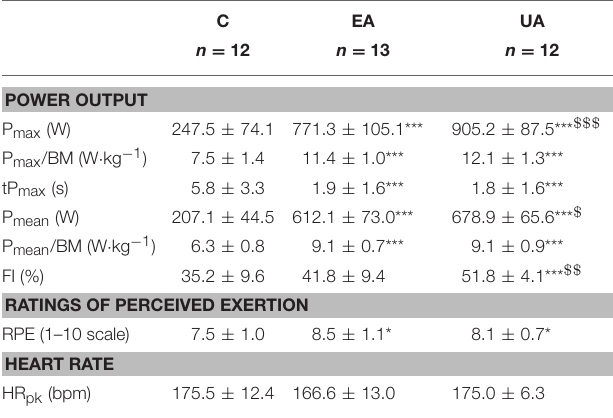
TABLE 2 | Performance outcomes during the Wingate test in prepubertal children, untrained adults and well-trained adult endurance